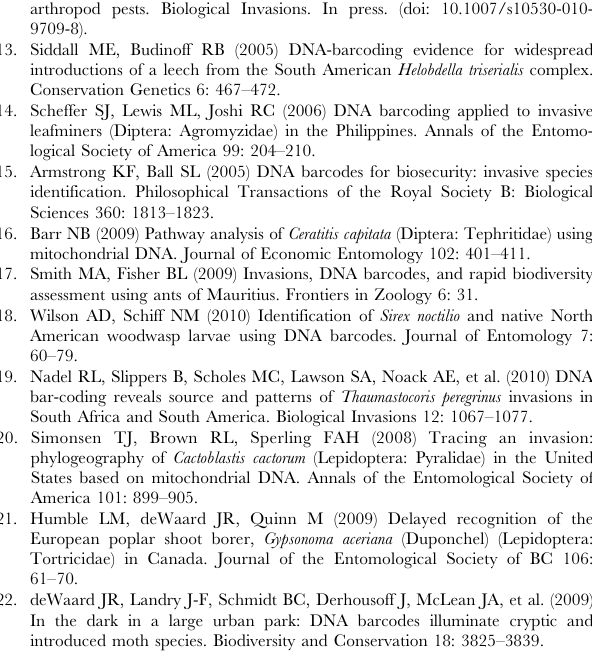
Table S1 Taxonomic samples used in study, including Barcode of Life Database (BOLD) and GenBank accessions. Also listed is the presence ( + ) or absence (-) of the NlaIII (N) and BamHI (B) restriction enzyme sites of the ‘NB system’ [24], determined from the sequence data (i.e. not by performing the